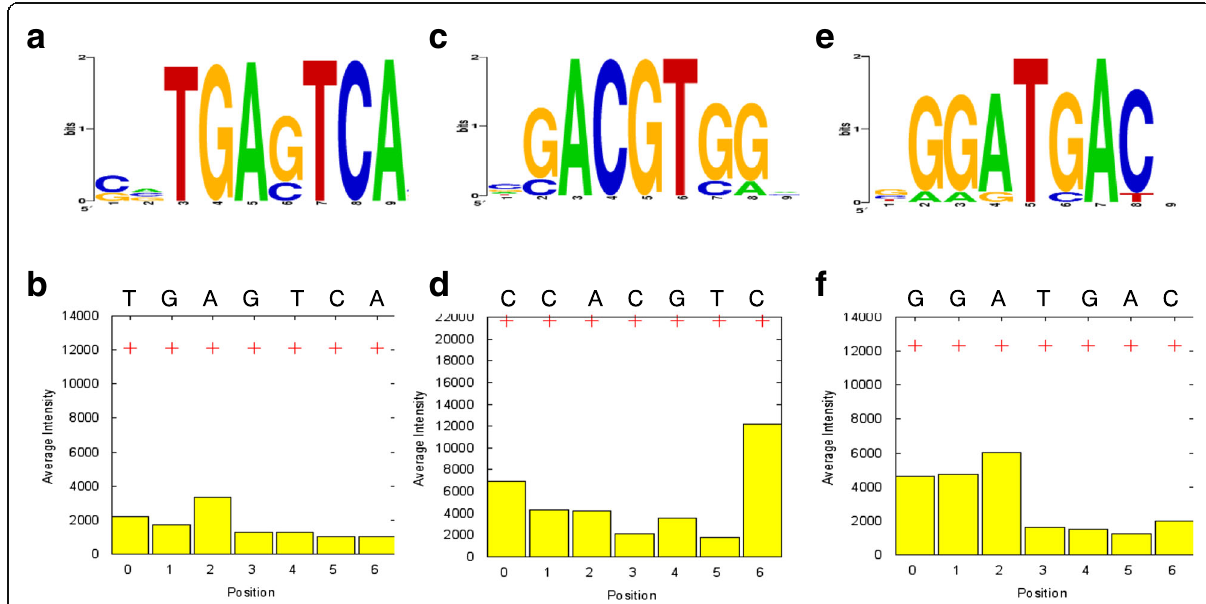
Fig. 2 Identification of binding motifs of recombinant OsSMF1 from E. coli by Q9-PBM. a, c, e The consensus binding sequences according to the binding intensities observed on the Q9 protein-binding microarray. The overall consensus binding motif was obtained by multiple alignments of the significant binding sequences with ClustalW, and it was visualized with SeqLogo program. b, d, f The effects of mutations on the binding intensities of the consensus binding motif. The average binding intensities (+) of probes containing TGAGTCA ( b ), CCACGTC ( d ), and GGATGAC ( f ) were plotted. The yellow boxes represent the average binding intensities of probes substituted at each position with other